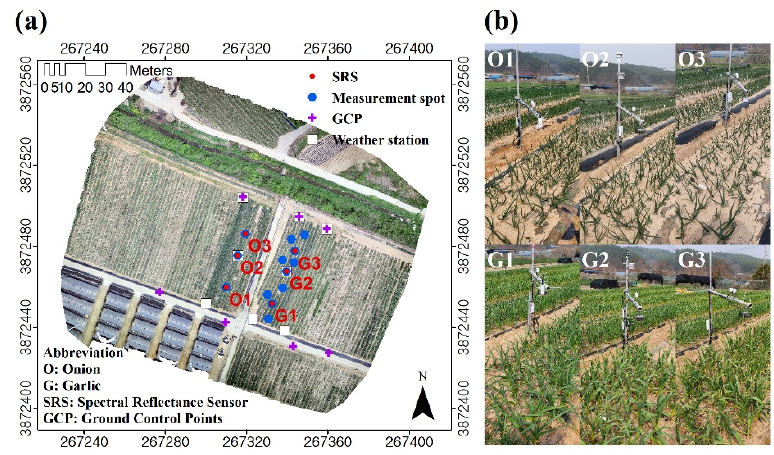
Figure 1. ( a ) Positions of the SRSs and optical measurement points; ( b ) photographs of SRSs at each position. Two field spectrometers (AvaSpec-UL2048L, Avantes BV, Apeldoorn, The Netherlands) were